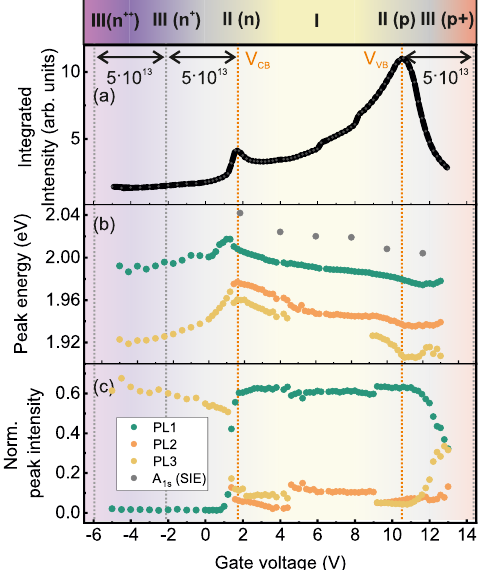
Figure 4. ( a ) Integrated emission intensities as a function of gate voltages from − 5 V ≤ V g ≤ 13 V from the spectra displayed in Figure 2a. The maxima indicate voltage values for which E F is aligned to CB and VB edges. The different doping regimes are highlighted. ( b ) Peak energies of the line-shape analysis using Gaussian profiles as a function of gate voltages for emission lines PL1, PL2 and PL3. The grey circles are the A 1 s energies from SIE measurements. Since the measurements were done on two different samples, the effective electric field transferred by the gate voltage is expected to slightly differ. ( c ) Intensities of the emission lines shown in ( b ) are normalized to the integrated emission energies shown in ( a